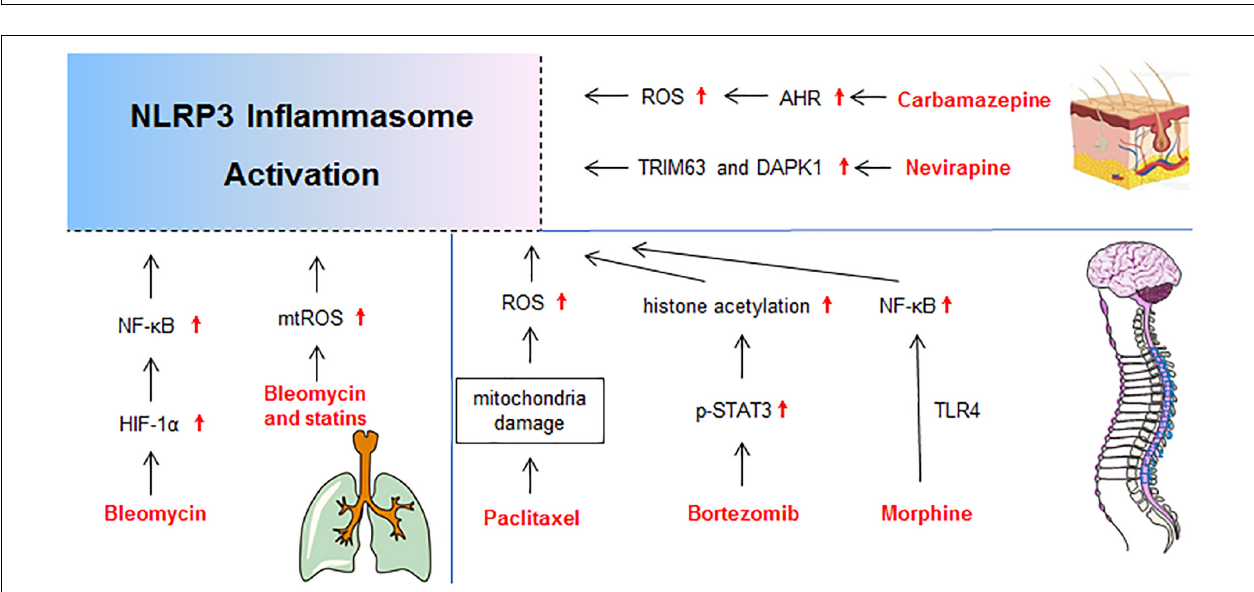
FIGURE 5 | Molecular mechanisms of NLRP3 activation in drug-induced gutaneous reaction, neurotoxicity, and lung injury. DAPK1, death-associated protein kinase 1; p-STAT3, phosphorylation-signal transducer and activator of transcription-3; TRIM63, Tripartite Motif-containing Protein 63.